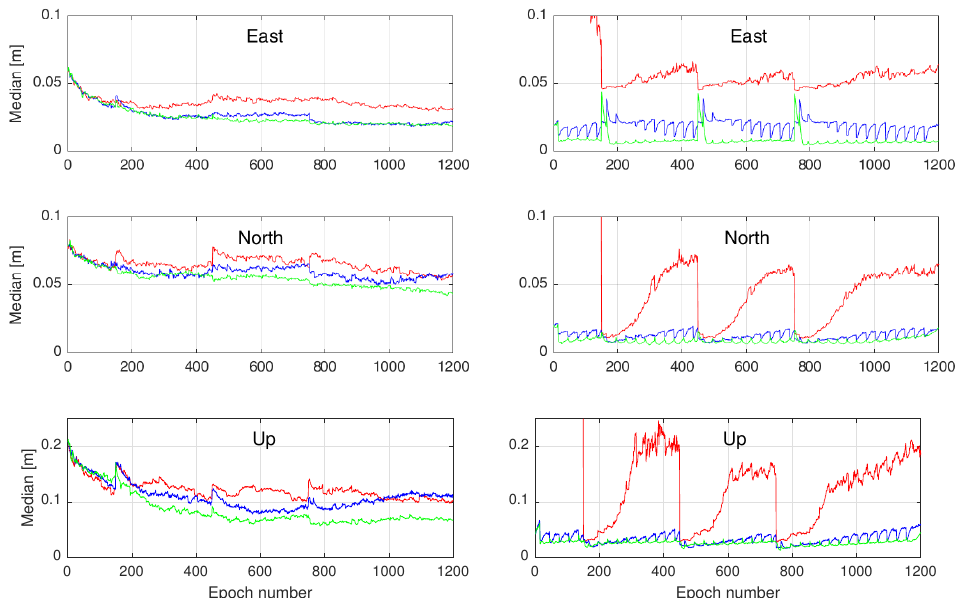
Figure 8. Medians (50% percentiles) of the absolute positioning errors corresponding to 300 user-filter realizations before ( left ) and after ( right ) ambiguity-fixing in the East–North–Up directions when the correction packs are provided with a time-delay (cf. Figure 5). The results of Cases 1, 2, and 3 are indicated in red, blue, and green,